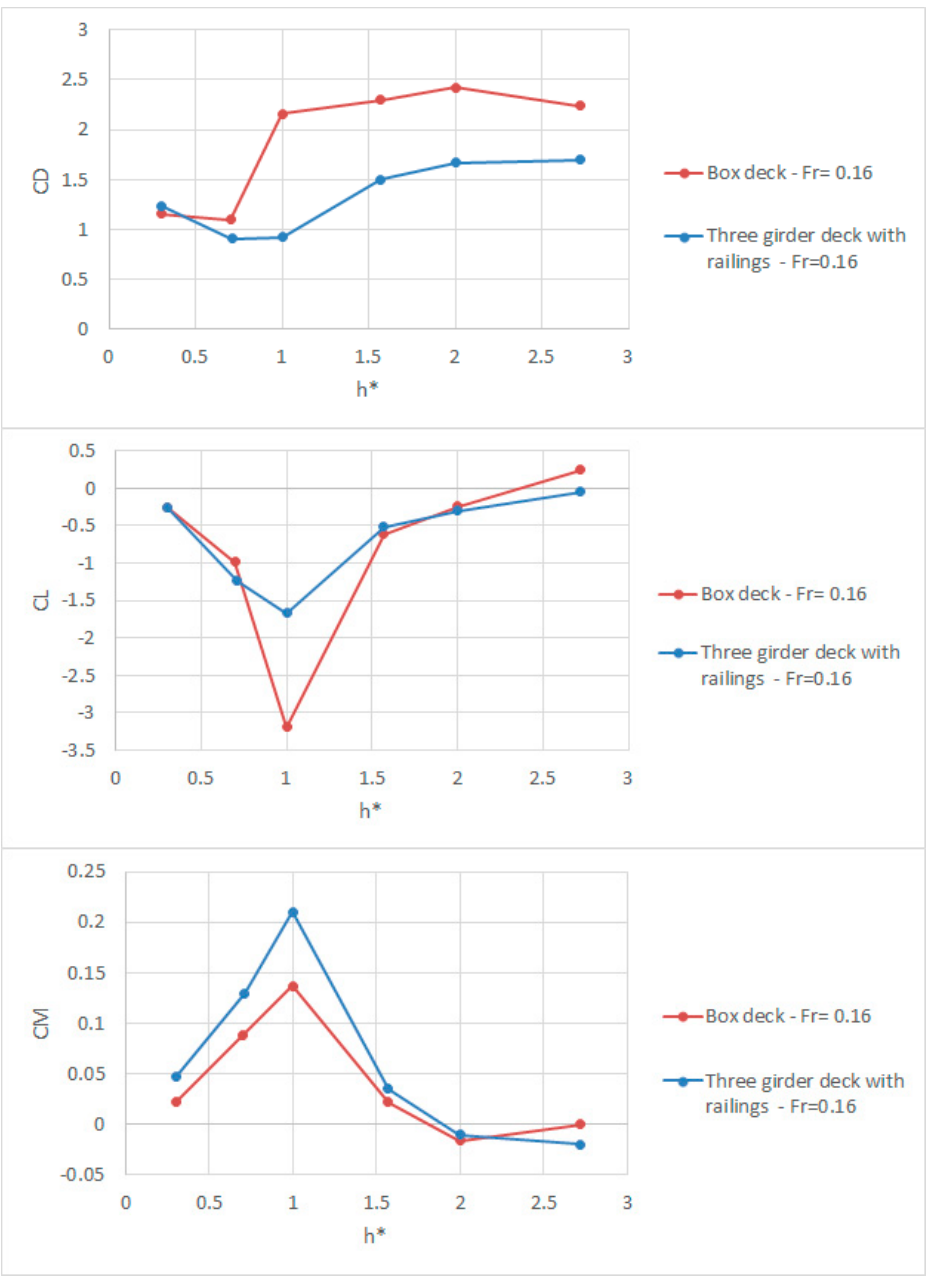
Figure 30. Comparison of force and centroidal moment coefficients between the box deck and three girder deck.